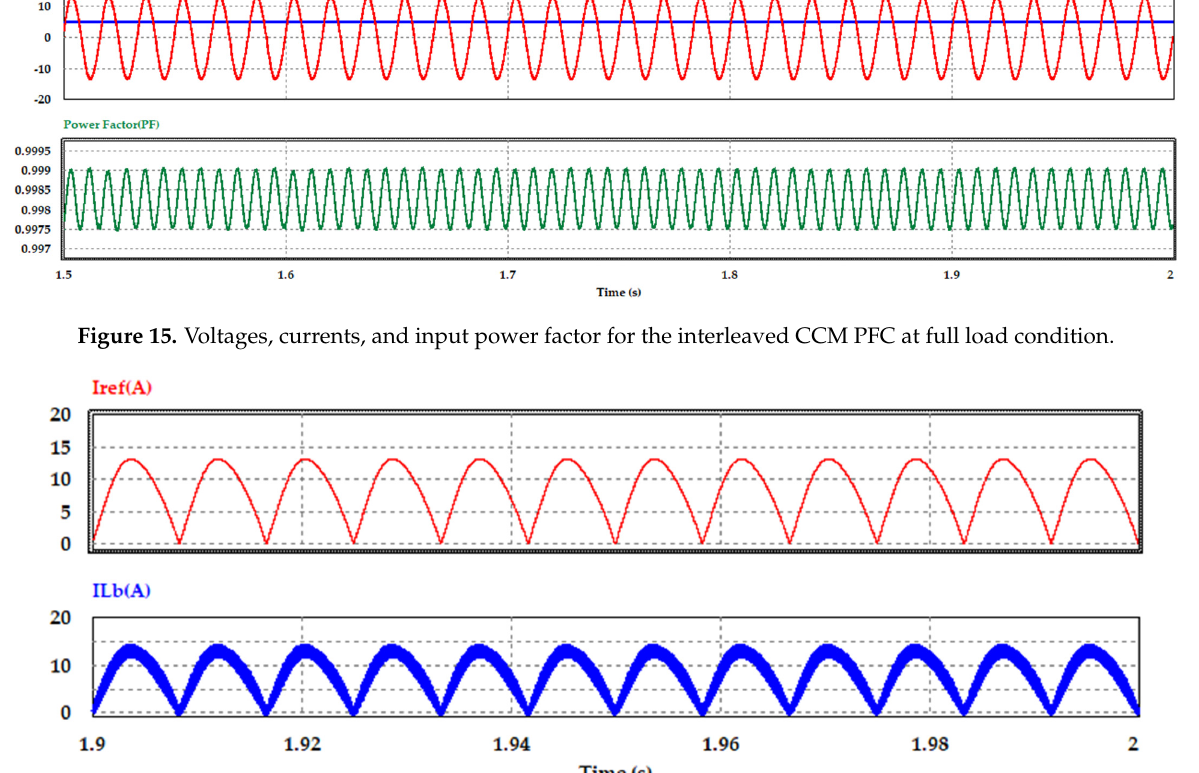
( b ) Figure 13. PSIM simulation circuit for the PFC topologies: ( a ) conventional boost PFC; ( b ) interleaved boost PFC.